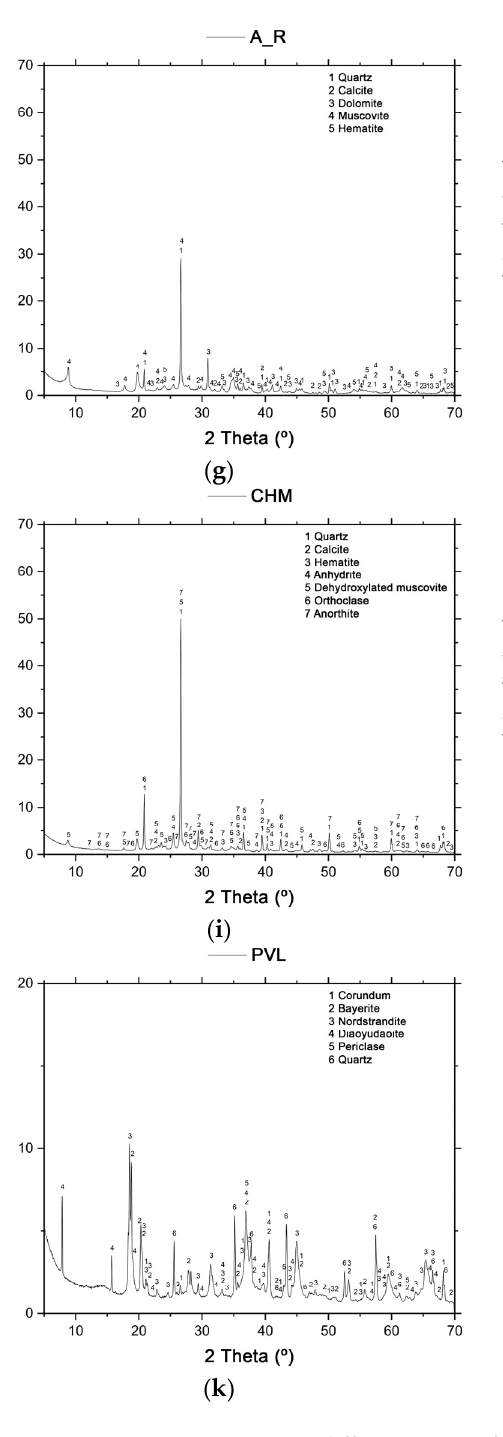
Figure 3. X-ray diffractograms of: ( a ) C_A; ( b ) C_SN_1; ( c ) C_SN_2; ( d ) C_T; ( e ) A_A; ( f ) A_N; ( g ) A_R; ( h ) Y; ( i ) CHM; ( j ) MRM; ( k ) PVL.